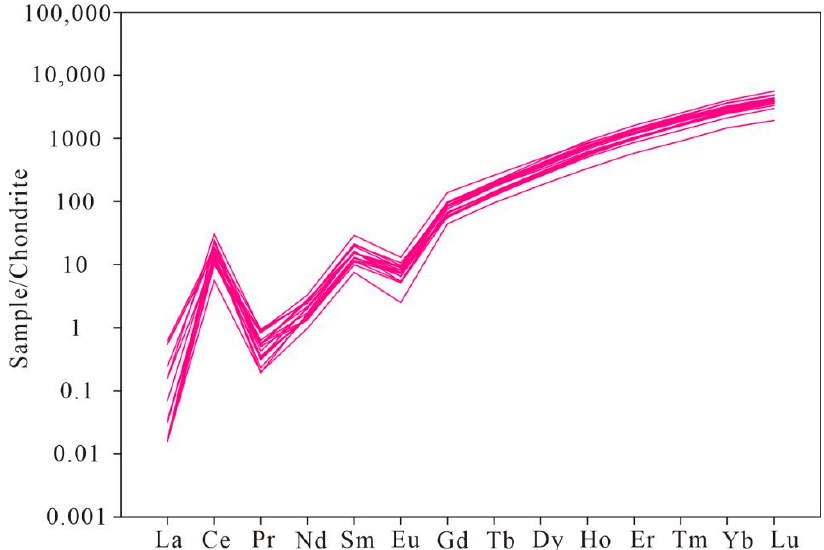
Figure 5. Chondrite-normalized REE diagram of zircon grains from the Changdagou granodiorite porphyry. Normalizing values from [48,49].